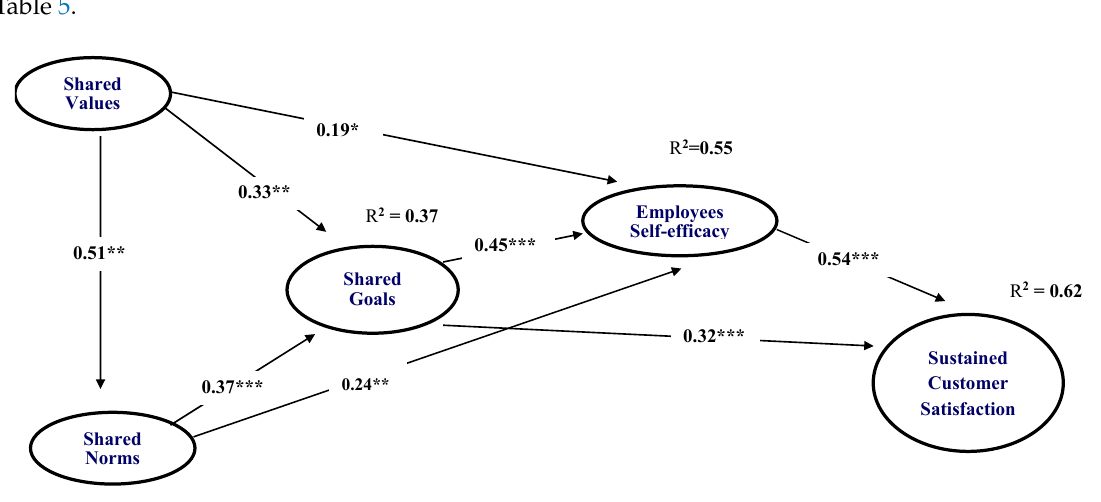
Figure 3. SEM results for the research model. * p < 0.05; ** p < 0.01; *** p < 0.001. Table 5. Summary of SEM results for the proposed model.